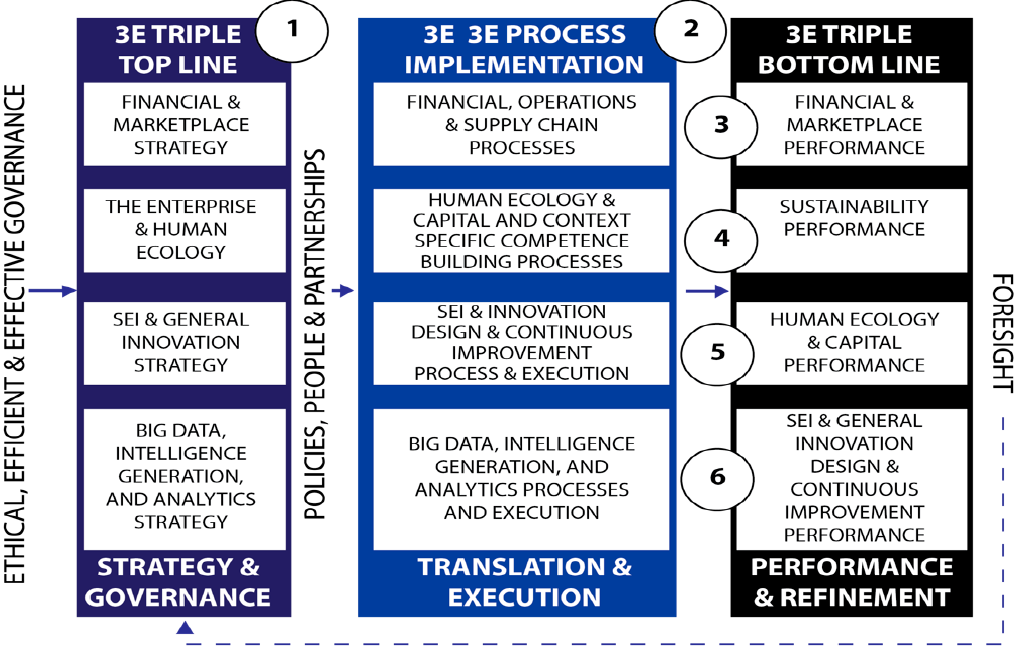
Figure 7. SEER2 model framework (reproduced with permission from [79] (p.